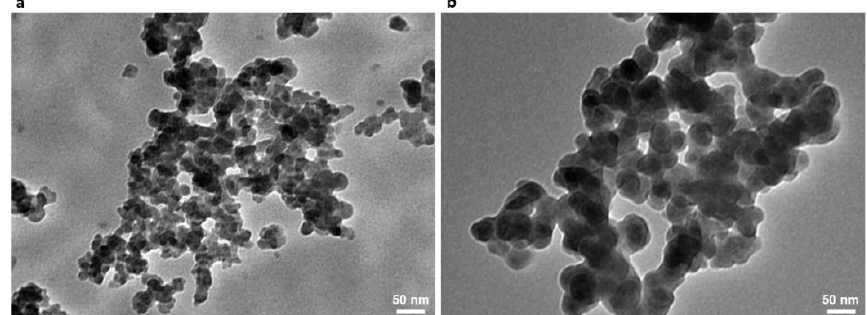
Figure 2. Transmission electron microscopy (TEM) images of ( a ) pristine SiO 2 nanoparticles (NPs) and ( b ) as-synthesized DOPO- t -SiO 2 NPs.